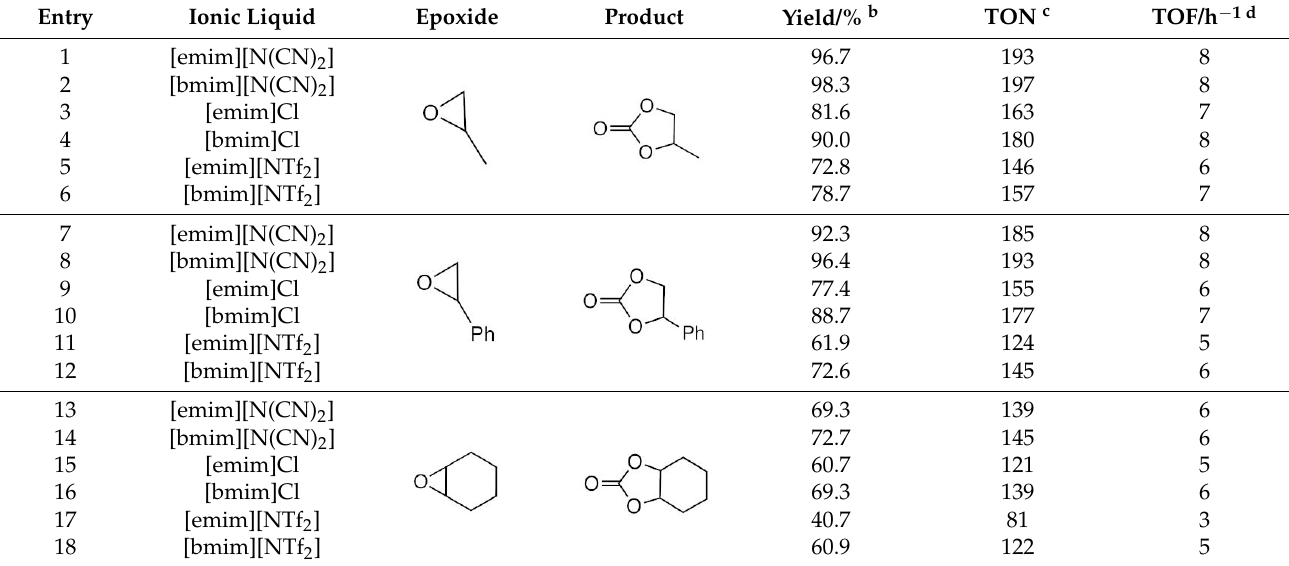
Table 1. Selected data a for the cycloaddition of CO 2 to epoxides catalyzed by [FeCl 2 { κ 3 -HC(pz) 3 }] in different ionic liquid (IL) media.